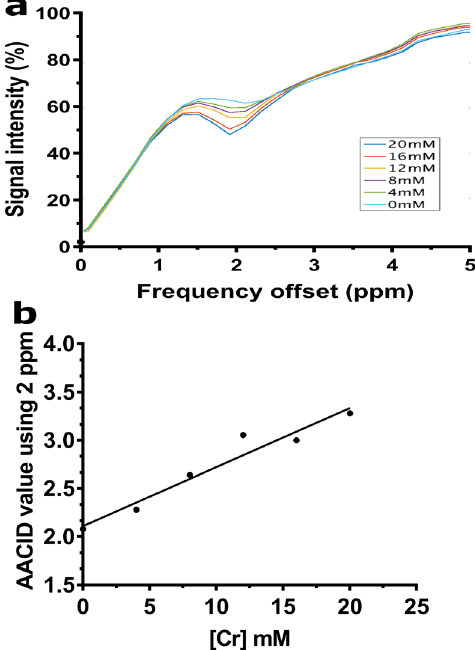
Figure 2. ( a ) CEST spectra acquired at 9.4T are shown for samples with Cr concentrations ranging from 0–20 mM mixed in 10% bovine serum albumin (BSA) at 37 °C and pH 7. ( b ) The AACID value shows a linear increase proportional to the increase in creatine concentration when using the 2 ppm resonance at constant pH. The average AACID 2.75 value in U87MG tumors was 1.15 ± 0.05, while the average AACID 2.75 value in contralateral tissue was 1.27 ± 0.041. The average AACID 2.0 value in U87MG tumors was 1.93 ± 0.11 while the average AACID 2.0 value in contralateral tissue was 2.12 ± 0.10. In both cases, the AACID value in the tumor was significantly lower ( p < 0.05) than the contralateral side, indicating a more basic pH in the tumor. The average difference in AACID values between U87MG tumors and contralateral tissue in the 24 mice studied was 39% greater when using the 2 ppm amine resonance compared to the 2.75